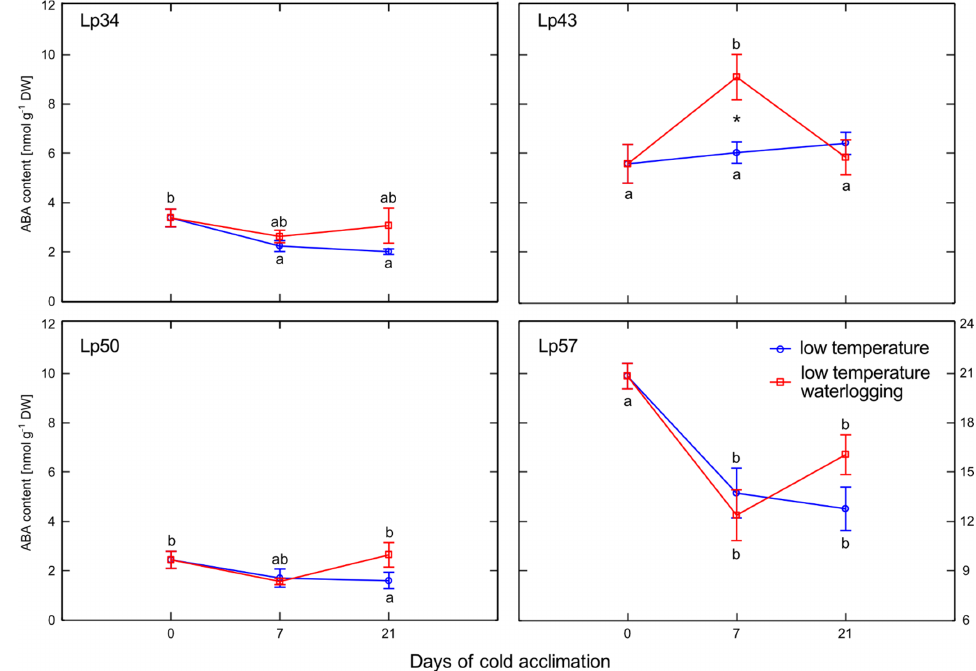
Figure 5. Abscisic acid (ABA) content of cold-acclimated Lolium perenne genotypes. Four genotypes (Lp34, Lp43, Lp50, and Lp57) were tested. The results are means ( n = 4), error bars indicate the standard error. Asterisks indicate means that differ significantly between waterlogged and control plants according to one-way ANOVA ( p < 0.05). Different lower-case letters indicate means that are statistically different according to Duncan’s multiple range test ( p < 0.05). 2.6. Glucose content Decreases in glucose content in response to waterlogging were observed in Lp34, Lp50, and Lp57 plants after 7 and 21 days of cold acclimation, and in Lp43 plants after 21 days of cold acclimation (Figure 6). A relatively high glucose content in Lp43 after 7 days of cold acclimation coincided with an increase in ABA content. Therefore, induction of ABA accumulation might be associated with a relatively high glucose content.